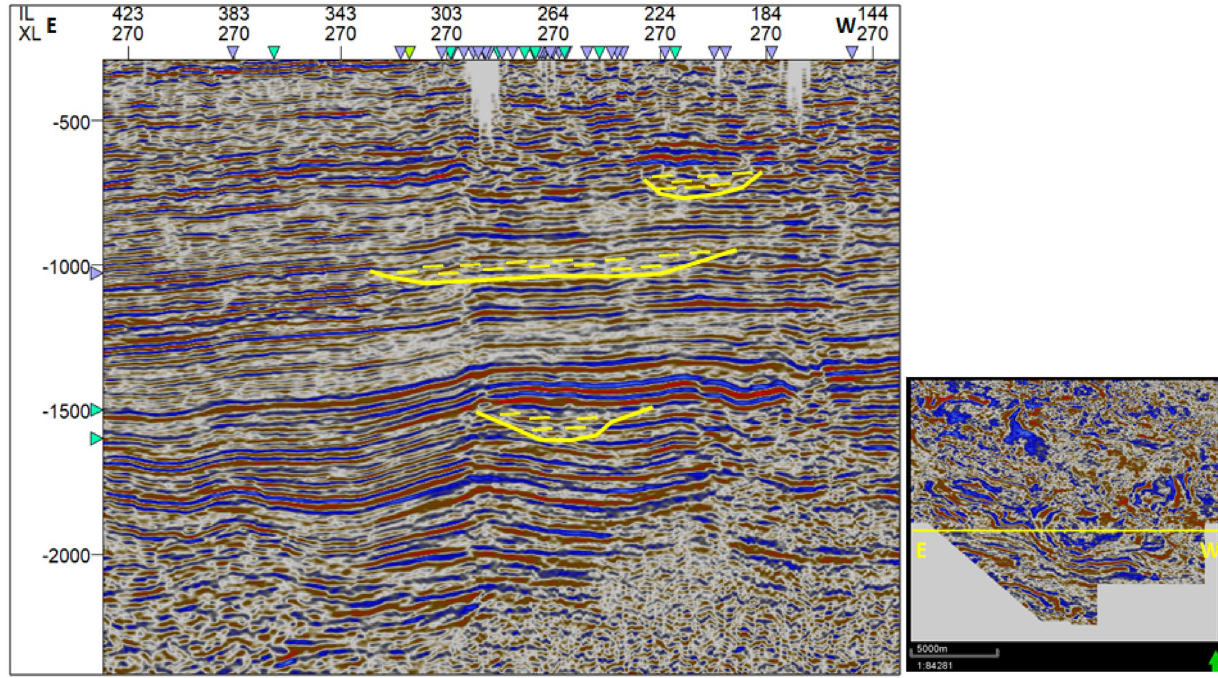
Fig. 11 Channel incisions up-north from Izombe seismic survey—line